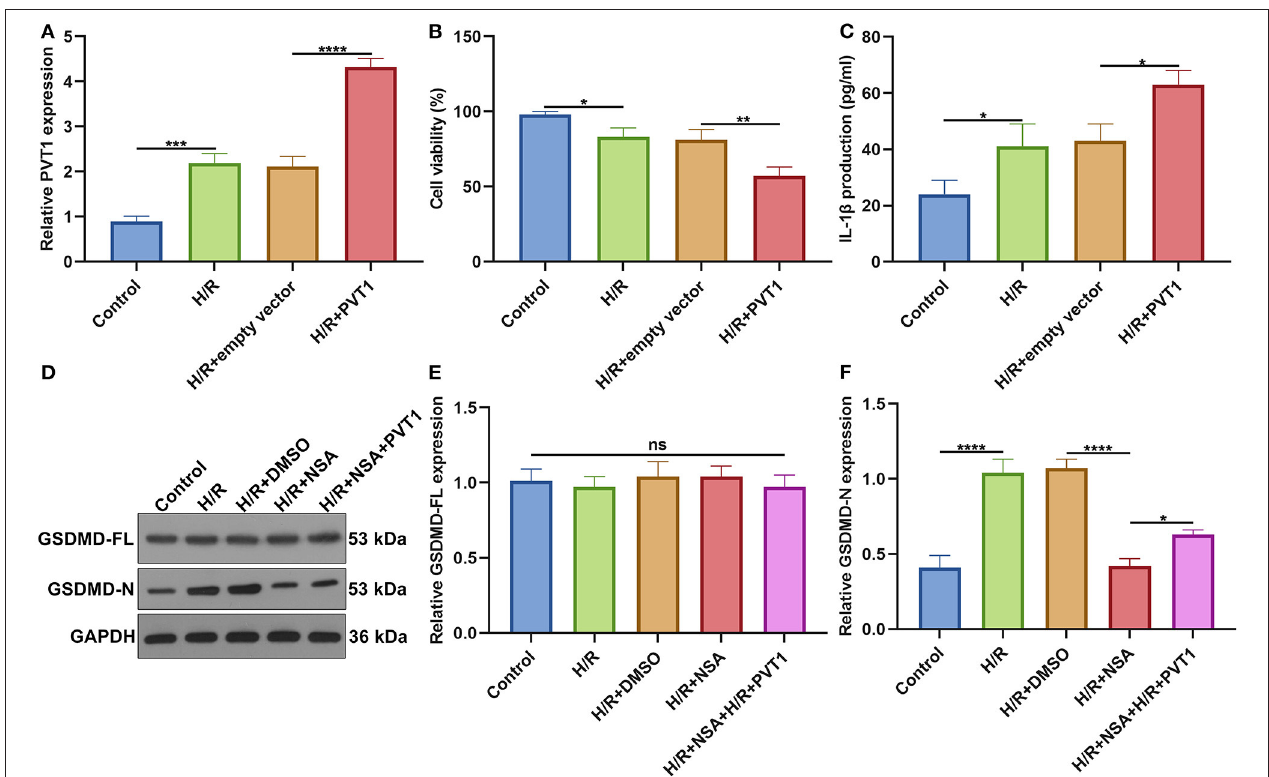
FIGURE 8 | Overexpression of lncRNA PVT1 promotes H/R-mediated pyroptosis in H9C2 cells. (A) RT-qPCR for the expression of PVT1 in H9C2 cells in four groups: control, H/R, H/R + empty vector, and H/R + PVT1 groups. H9C2 cells in the H/R, H/R + empty vector, and H/R + PVT1 groups were treated by H/R for 4h. For the H/R + empty vector and H/R + PVT1 groups, H9C2 cells were transfected by plasmids of 500 ng pcDNA3.1 vector (empty vector) or 500 ng PVT1 for 48h. No treatment was done for H9C2 cells in the control group. (B) CCK-8 for the cell viability of H9C2 cells in above groups. (C) ELISA for IL-1 β levels in the cell supernatant in above groups. (D–F) Western blot of (E) GSDMD-FL and (F) GSDMD-N expressions in H9C2 cells in five groups: control, H/R group, H/R + DMSO, H/R + NSA, and H/R + NSA + PVT1 groups. H9C2 cells were treated with 25nM NSA, followed by plasmids of 500 ng PVT1 and H/R treatment. Each experiment was repeated three times. Ns: not significant; * p < 0.05; ** p < 0.01; *** p < 0.001; **** p <